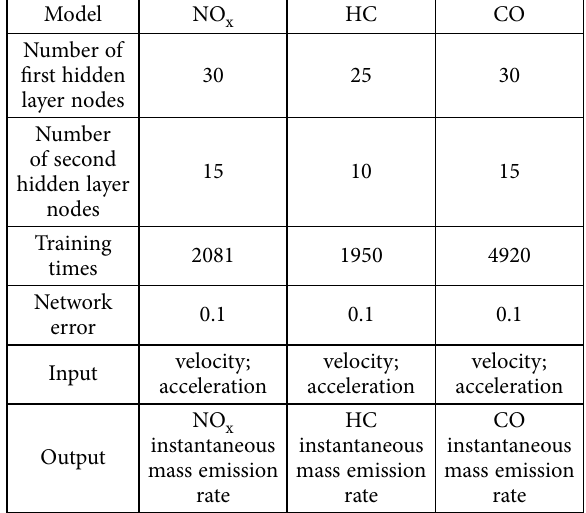
Table 5. Parameters of neural network model